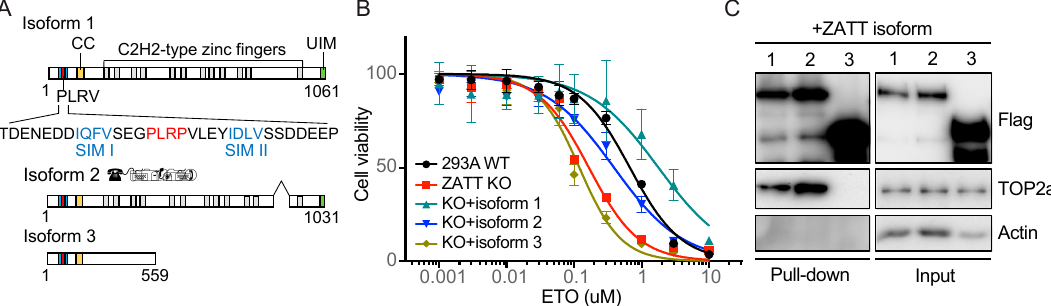
Figure 2. ZATT isoform 3 was not able to rescue ETO sensitivity in ZATT KO probably due to a lack of interaction with TOP2 ( A ) Schematic diagrams of ZNF45 isoforms. ZATT isoform 1 consists of 2 N-terminal SUMO interacting motifs (SIMs), 11 zinc finger domains, and a ubiquitin interacting motif (UIM). ( B ) ZATT KO cells were transfected with constructs encoding SFB ‐ ZATT isoform 1, isoform 2, and isoform 3. Cell survival was measured by a CellTiter ‐ Glo assay after 3 days in the presence of the indicated concentrations of ETO. Each experiment was repeated three independent times done in triplicate each time. ( C ) Cells were transfected with constructs encoding SFB ‐ ZATT isoforms and subjected to pull ‐ down with streptavidin. Western blotting was conducted with antibodies as indicated. The input lanes contain 2% of input protein.